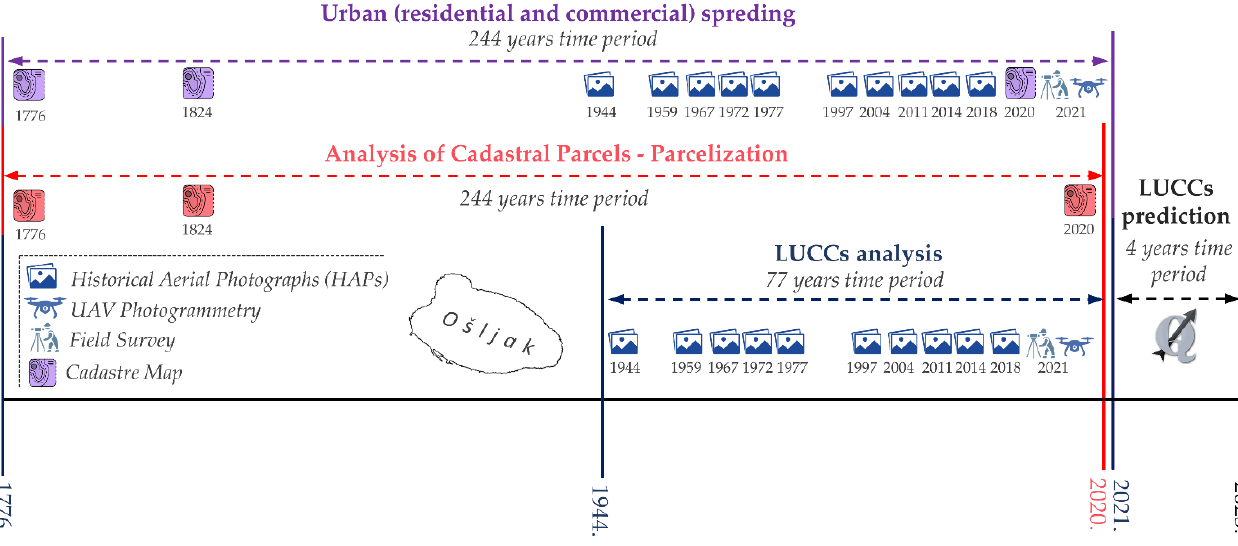
Figure 3. Timeline of acquired and collected multi-temporal data and time periods for which analyzes were made .